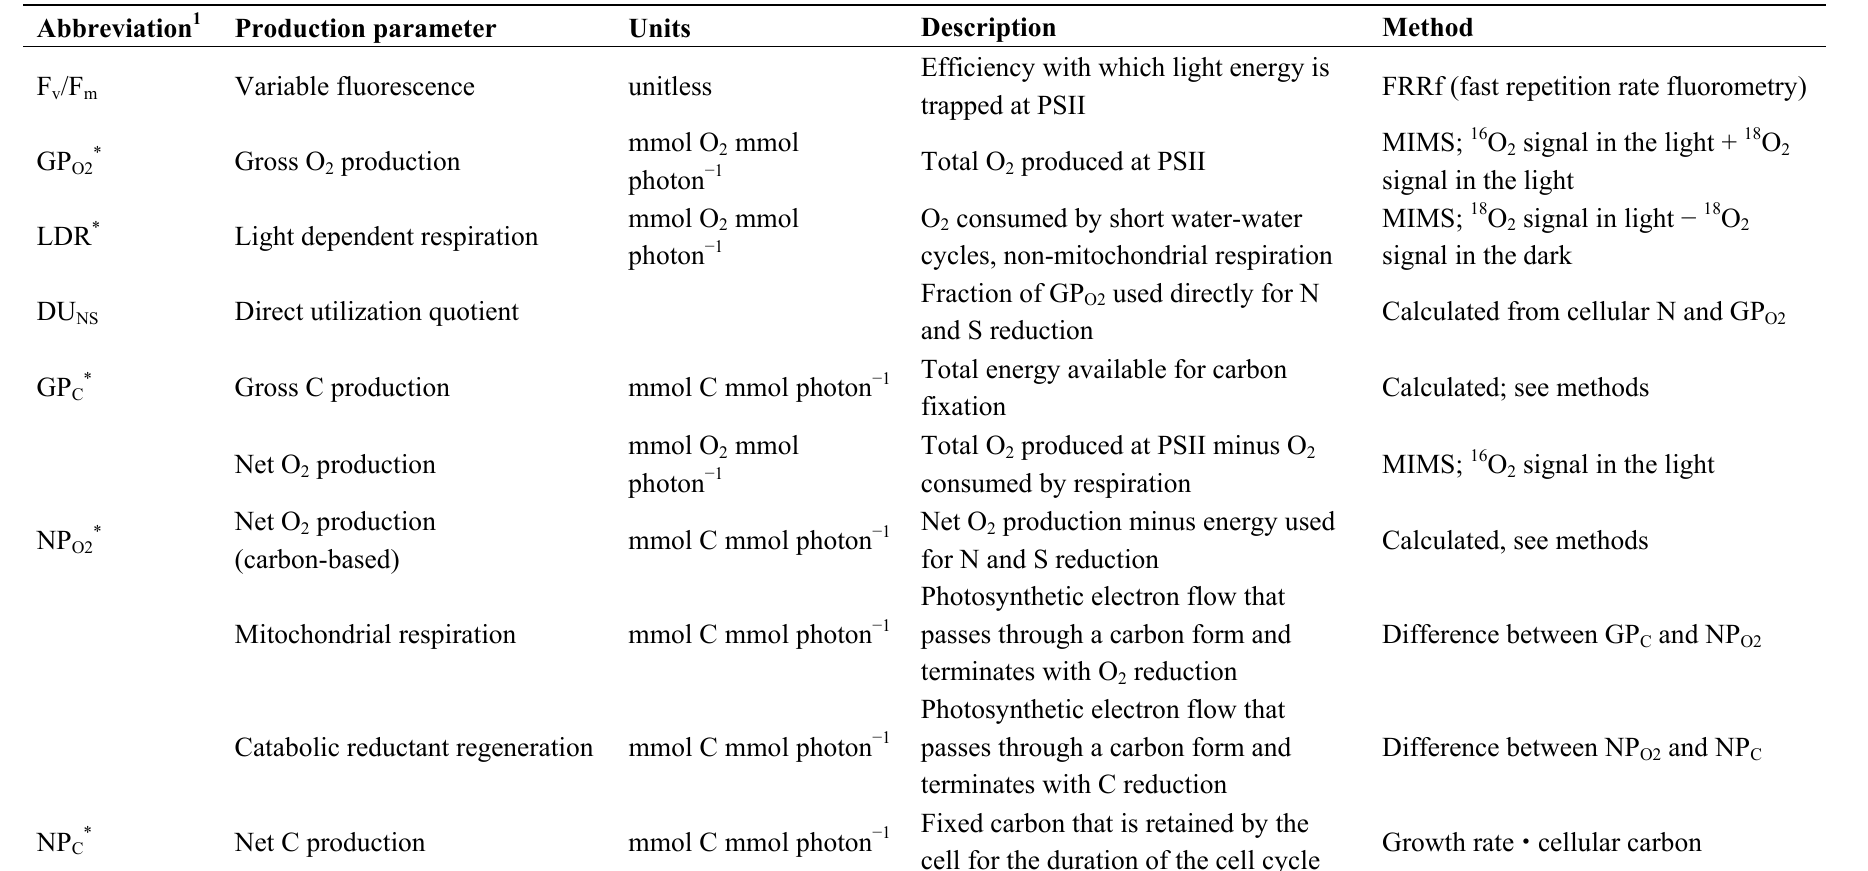
Table 2. Descriptions of production measurements and major metabolic pathways assessed in this